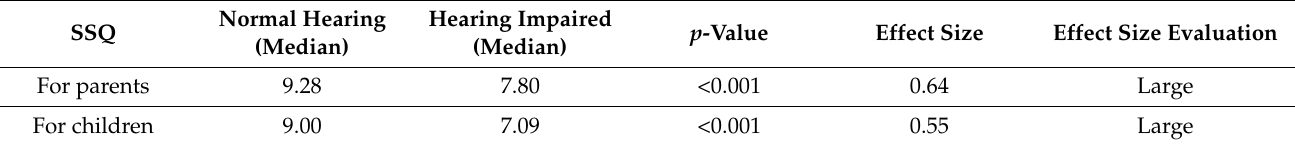
Table 2. SSQ for parents and children in the normal-hearing and hearing-impaired children